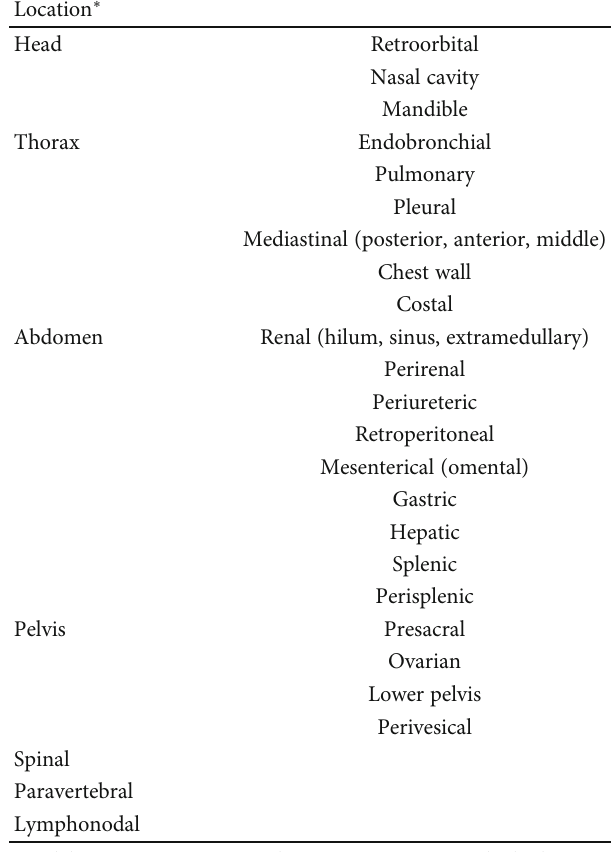
Table 1: Extra-adrenal location of myelolipoma [2]. Location